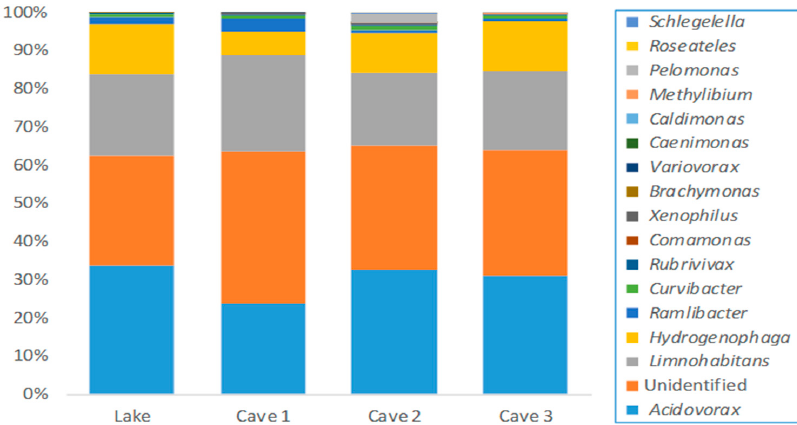
Figure 2. Relative abundance of the main genera of Comamonadaceae family detected in thermal waters of Lake, Cave 1, Cave 2, and Cave 3 of the Kaiafas thermal spring Anigrides Nymphes in Greece.